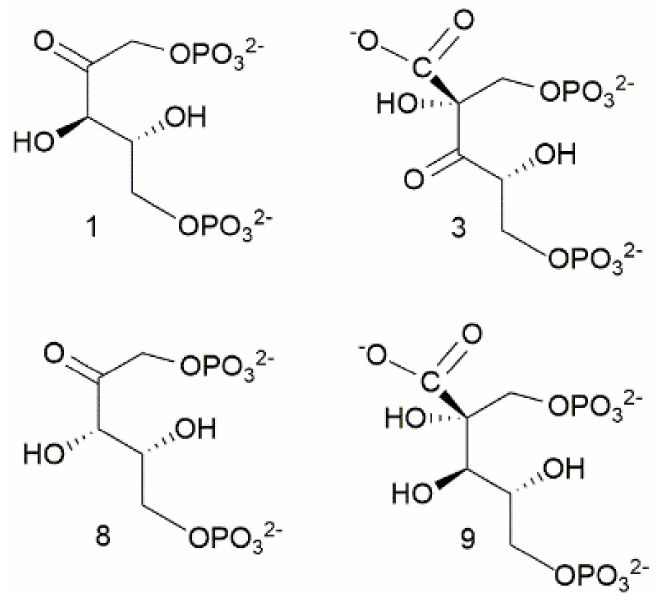
Scheme 2. Structure of: D-ribulose-1,5-bisphosphate (RuBP, 1 ), 2-carboxy-3-keto-arabinitol- 1,5-